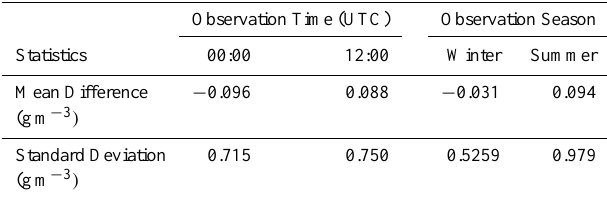
Table 1. The differences between surface humidity measurements and radiosonde interpolation (or extrapolation) data at all ground- based sites.